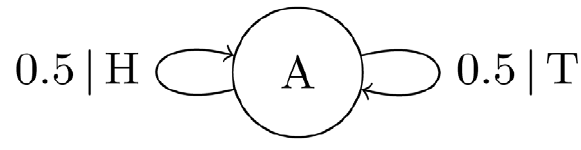
Figure 3. -Machine for the Fair Coin Process consisting of a single causal state S ~ f A g and a self-transition for both HEADS and TAILS. Each transition is labeled p D a to indicate the probability p ~ T ( a ) of taking that transition and emitting allele a [ A . We refer to the ij Biased Coin Process when p = 1 = 2 .